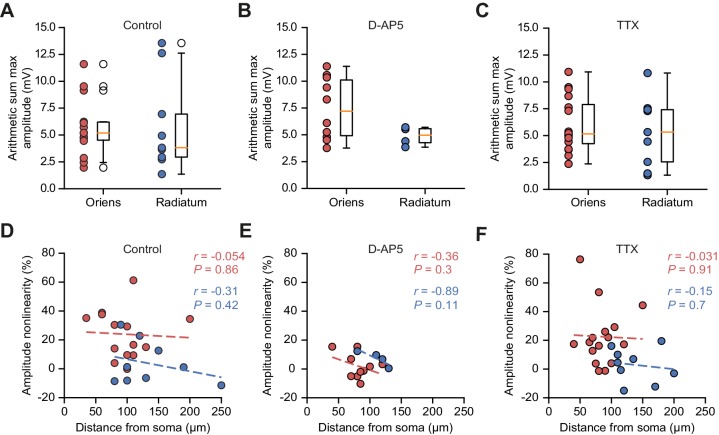
Arithmetic sum maximum uEPSP amplitudes, and integration nonlinearity vs uncaging location distances, across pharmacological conditions.(A – C) Peak arithmetic uEPSP amplitudes by uncaging dendrite location in control conditions (A, replotted from Figure 1—figure supplement 1B for comparison), D-AP5 (B), and TTX (C). (D – F) uEPSP peak amplitude nonlinearity vs uncaging location distance from soma in control conditions (D, replotted from Figure 1—figure supplement 4 for comparison), D-AP5 (E), and TTX (F).